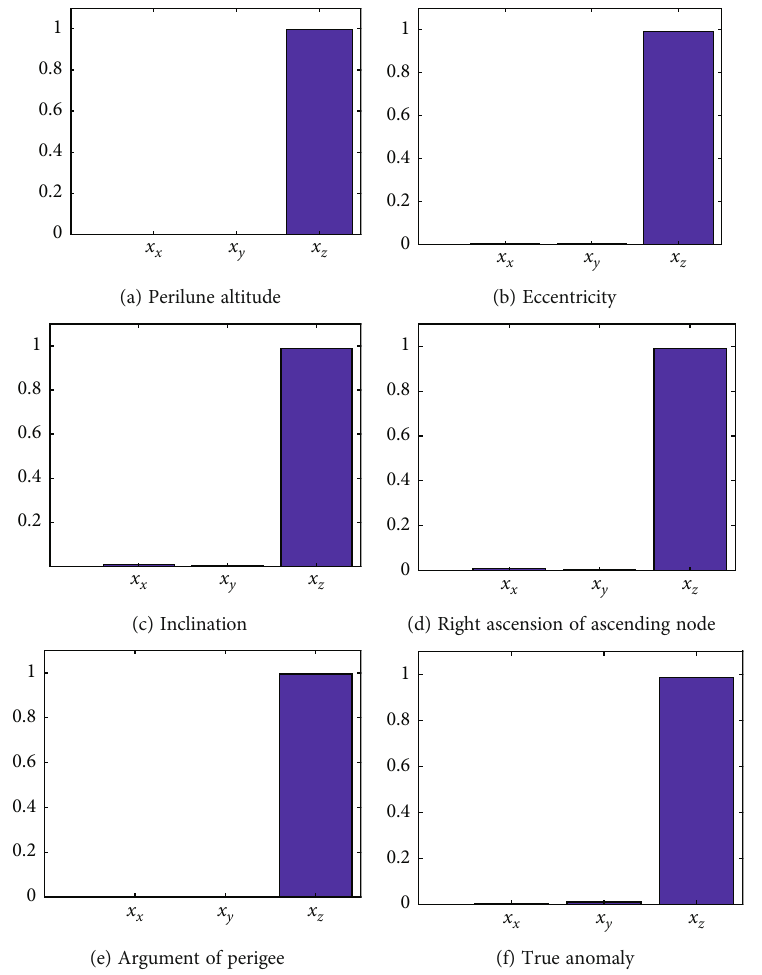
Figure 6: Histogram of the global sensitivity index of the position parameters to the orbital elements at the